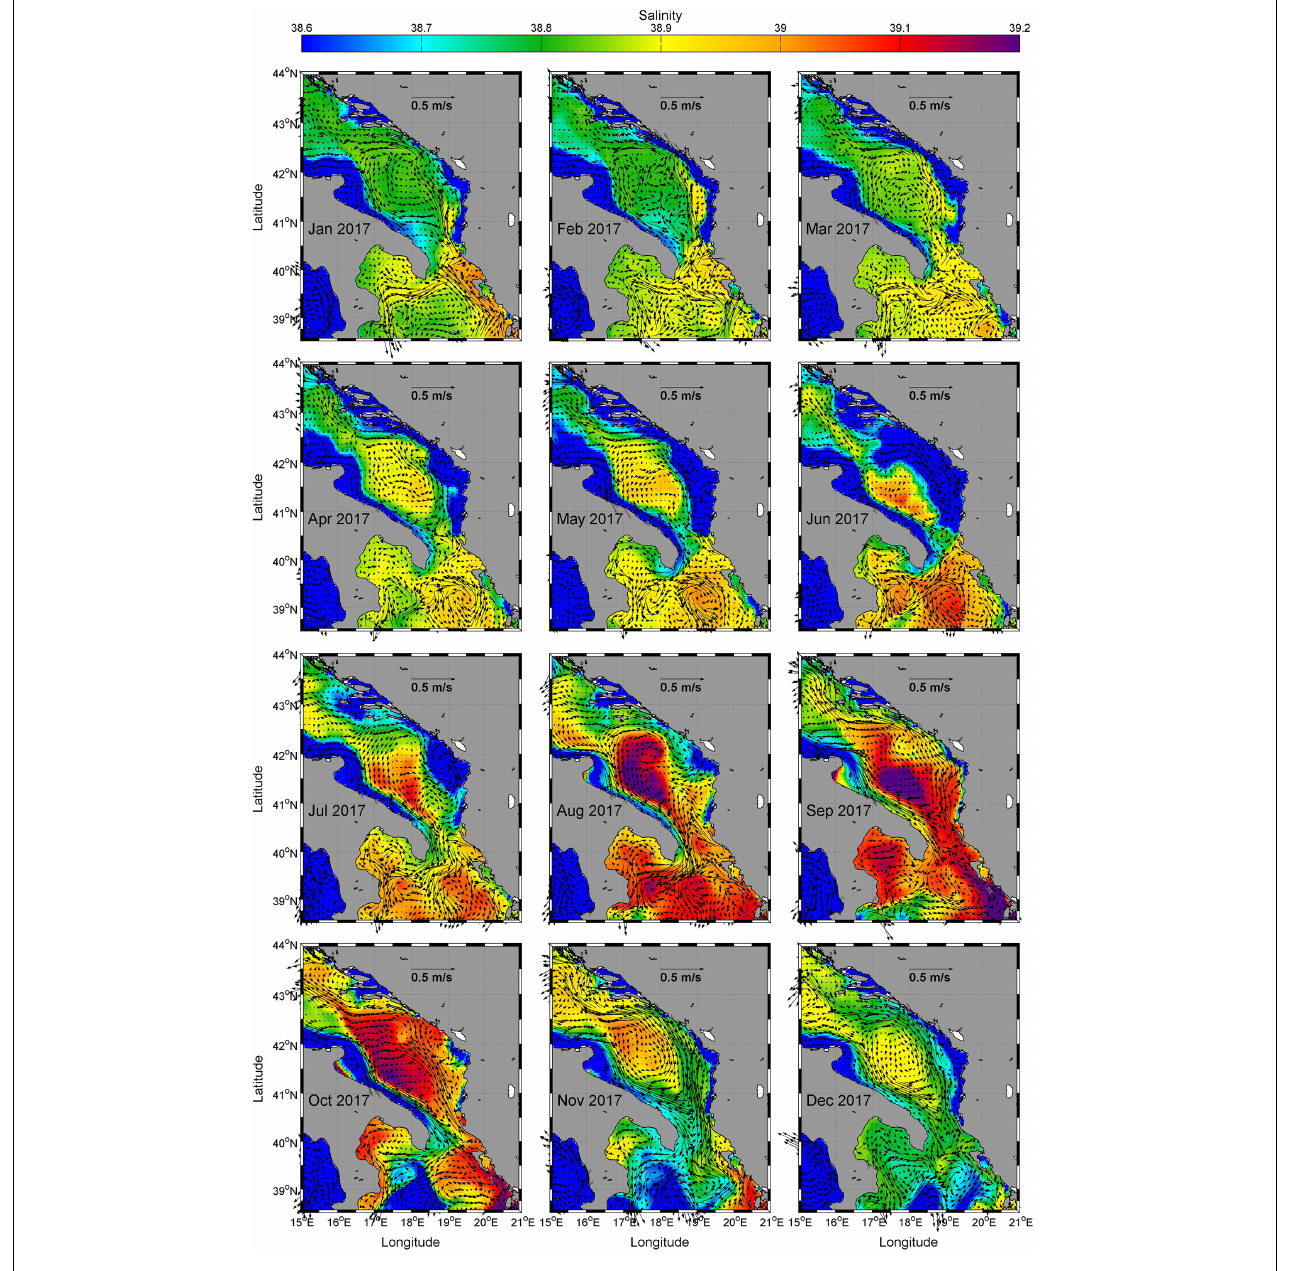
FIGURE 5 | Modeled surface currents (Mediterranean Forecasting System) and salinities, monthly averaged between January and December 2017.